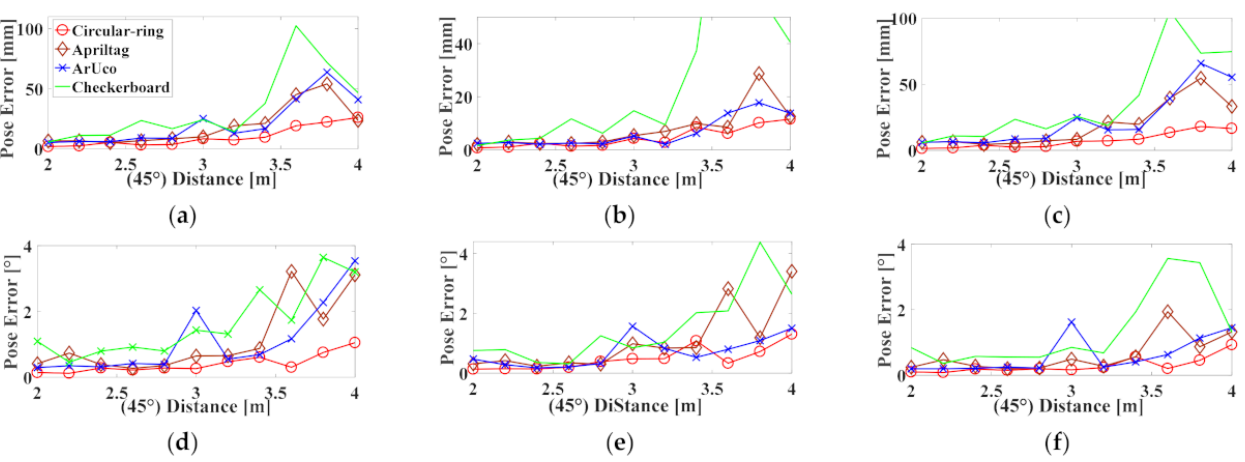
Figure 12. Six DoF correspond to repeatability errors when these markers at 45 ◦ : ( a ) Translation error along the X-axis; ( b ) Translation error along the Y-axis; ( c ) Translation error along the Z-axis; ( d ) Rotation error along the X-axis; ( e ) Rotation error along the Y-axis; ( f ) Rotation error along the